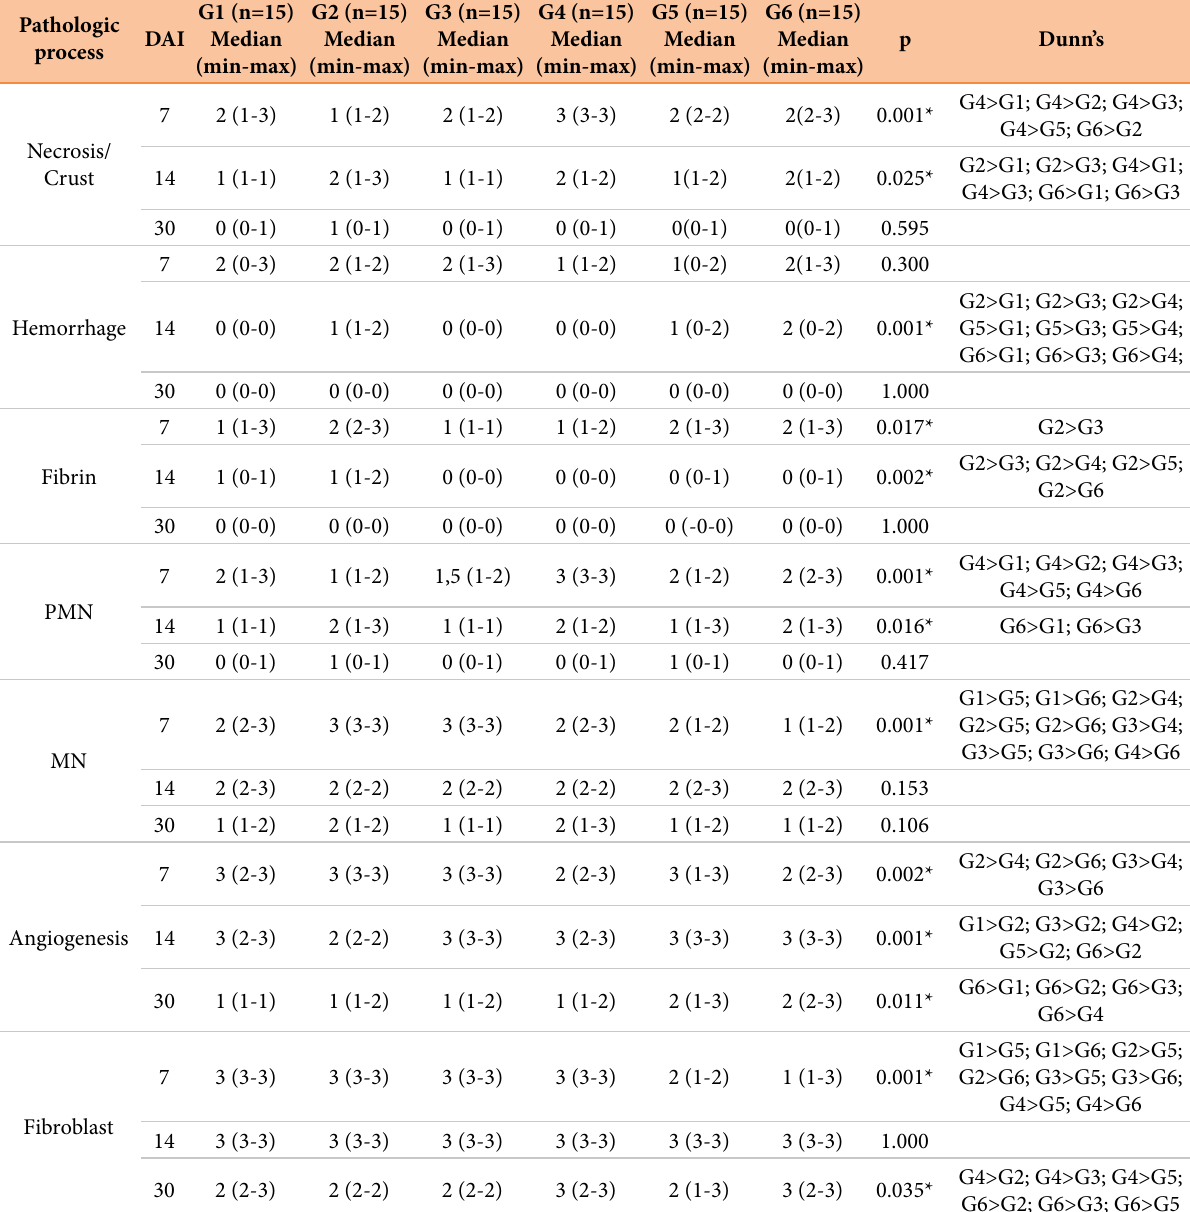
Table 2 - Microscopic analysis of the general pathologic processes in partial thickness burn wounds experimentally induced in Wistar rats and treated with silver-based